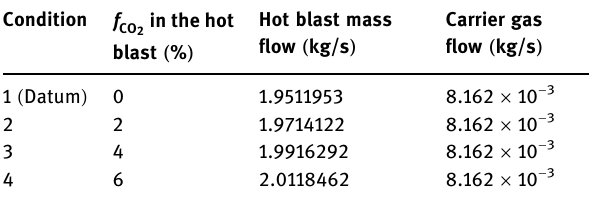
Table 3: Calculation of the operating mode entrance boundary condition settings